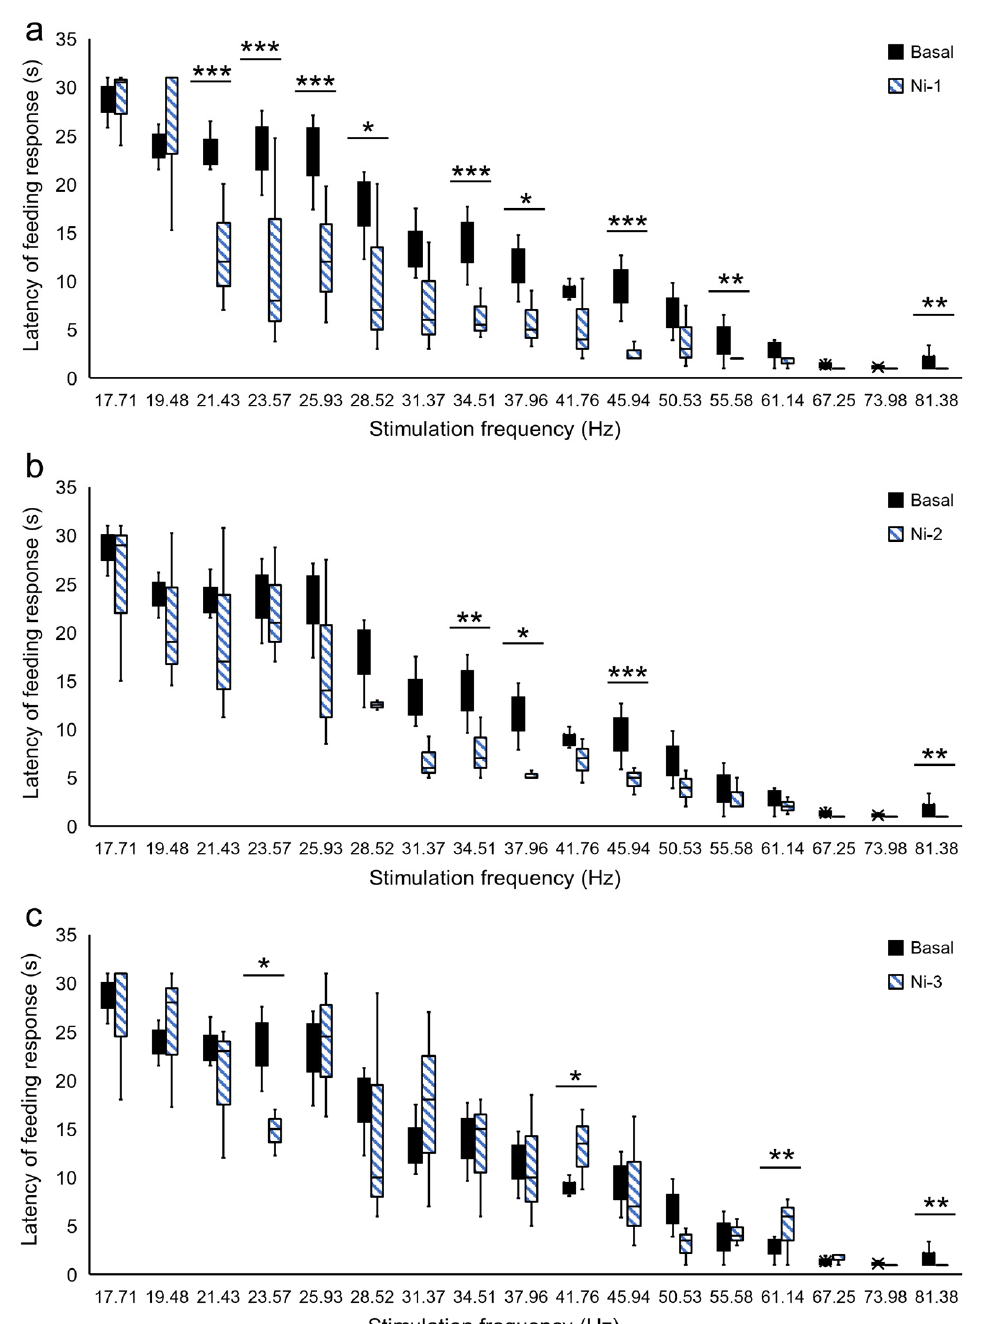
Figure 6. Destabilization of the VTA electrical stimulation (Es-VTA)-induced feeding response (FR) directly after different naloxone doses [2.5 µ g/0.5 µ L (Ni-1 group) ( a ), 5.0 µ g/0.5 µ L (Ni-2 group) ( b ), and 25.0 µ g/0.5 µ L (Ni-3 group) ( c )] injected into the PPN in the ipsilateral hemisphere (blue hatched bars) (n = 6 for each dose) compared to artificial cerebrospinal fluid (ACSF; 0.5 µ L) injected into the PPN as basal groups (black filled bars). * p < 0.05, ** p < 0.01, and *** p < 0.001 (Tukey’s post hoc test) indicate significant differences in the FR latency at different frequencies of Es-VTA in the Ni-1, Ni-2, and Ni-3 experimental groups compared to the basal group.